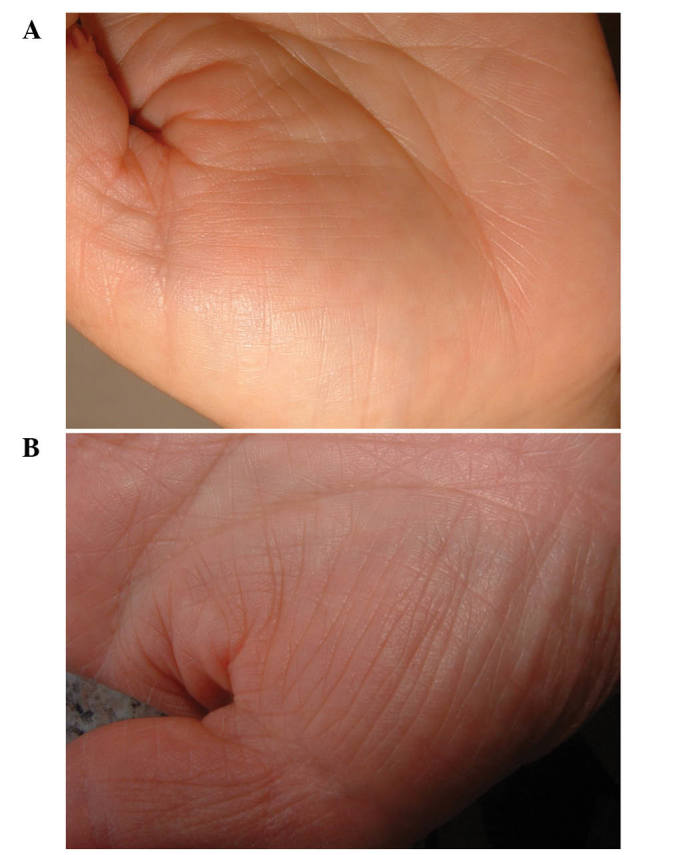
(A) Hand of a 71-year-old healthy female control whose palm dermatoglyphic was smooth with a few superficial grips in the greater thenar. (B) Hand of a 68-year-old female asthma patient whose palm dermatoglyph was rough and with numerous deep grips in the greater thenar.